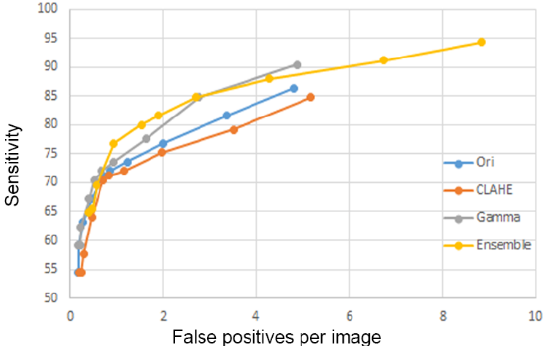
Figure 9. Sensitivity at different numbers of false positives of the original model, gamma correction model, CLAHE model, and ensemble models. CLAHE — CLAHE model; Gamma – Gamma correc- tion model; Ori — original model; FP — false positives.